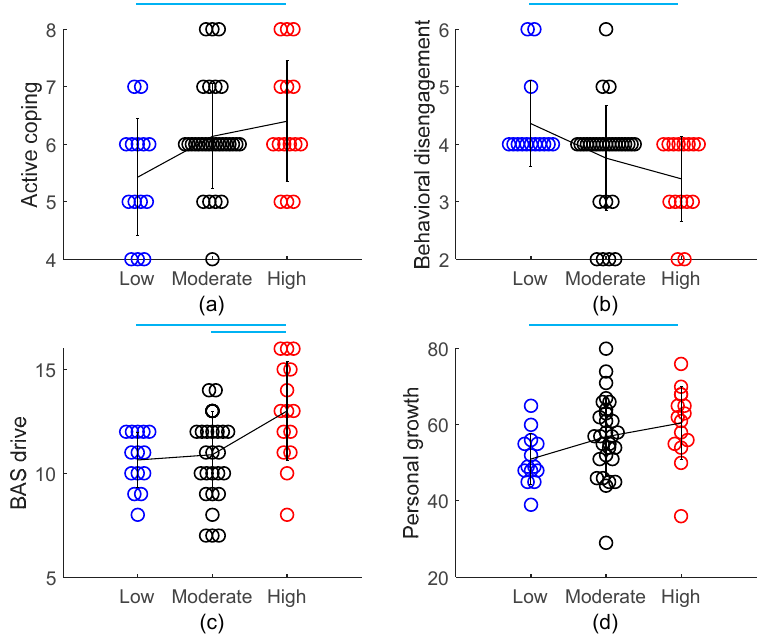
Figure 1. Comparison of active coping ( a ), behavioral disengagement ( b ), BAS drive ( c ), and personal growth ( d ) across di ff erent PA levels. n = 14, 29, and 15 for Low, Moderate, and High PA level, respectively. Each circle represents one data point from a single subject. Color indicates di ff erent PA levels. The black line connects the three PA levels at their mean value, and the vertical bar drawn on the mean value represents SD of subjects at that PA level. — indicates a significant between-group di ff erence ( p < 0.05) as suggested by post hoc comparisons. PA, physical activity; BAS, Behavioral Activation